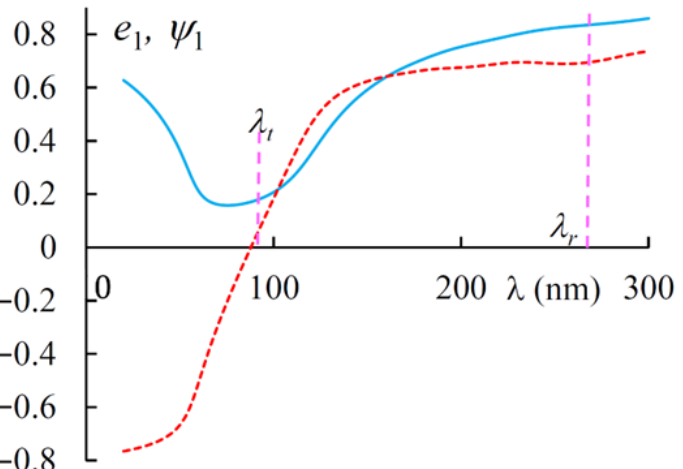
Figure 9. The spectra of ellipticity 𝑒 1 (solid line) and azimuth 𝜓 1 (dashed line) of the diffracting EP at g = 0.3.